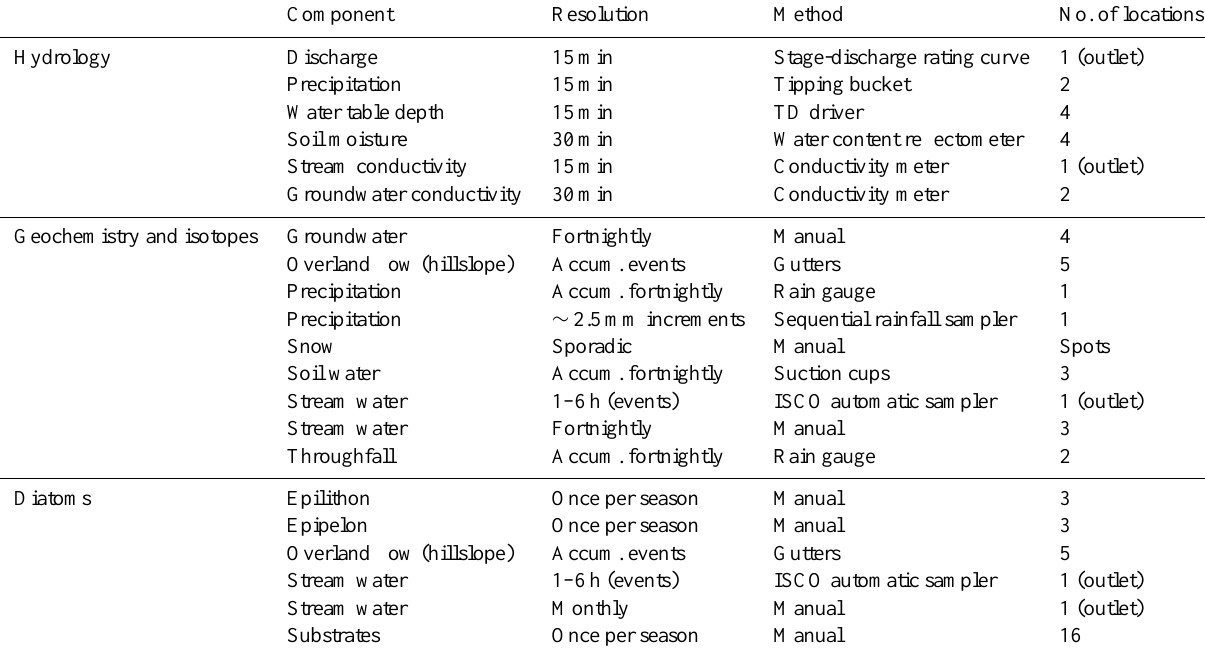
Figure 1. Detailed map of topography and instrumentation locations in the Weierbach catchment (northwest of Luxembourg City). Table 1. Summary of collection methods, sampling resolution and locations in the Weierbach catchment. Component Resolution Method No. of